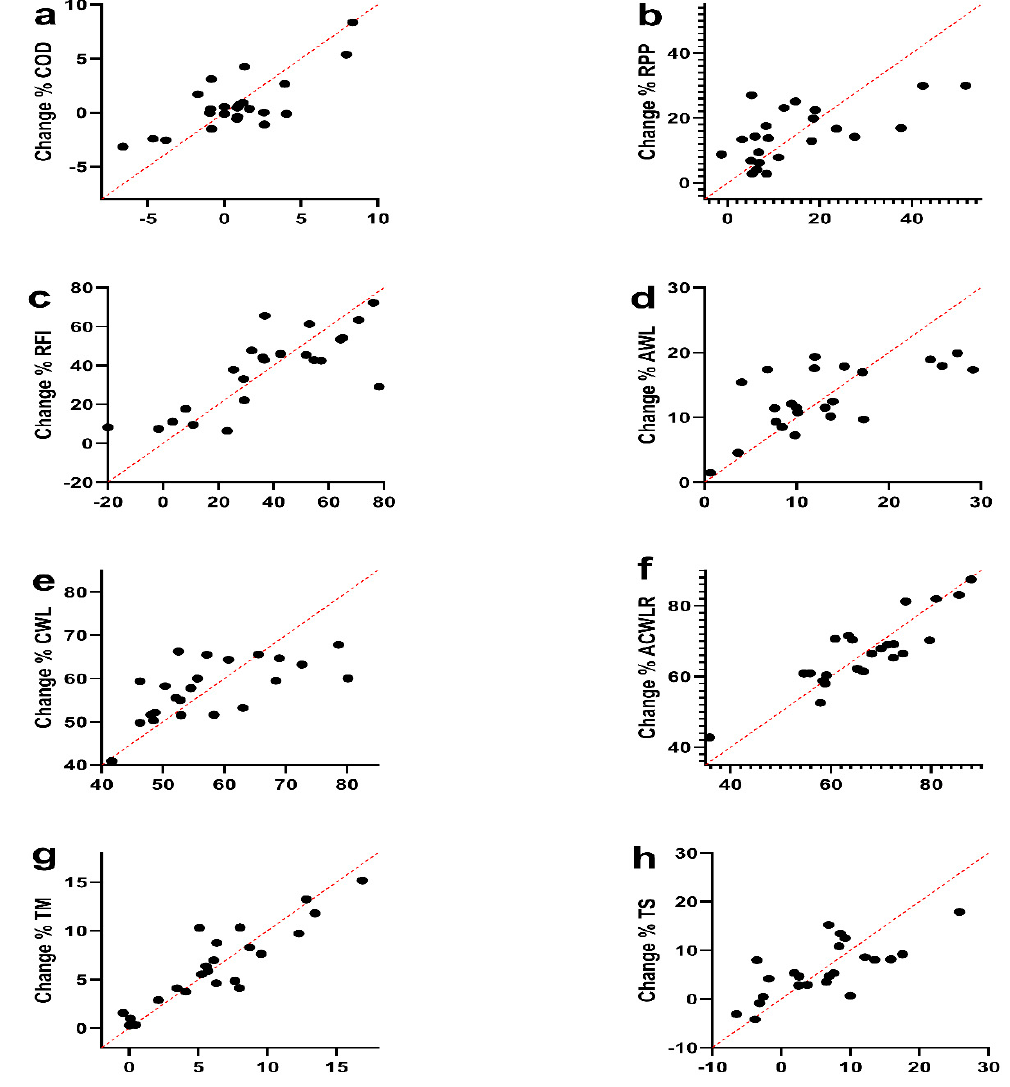
Figure 3. Multiple linear regression analysis was calculated to predict the percentage of change in fitness levels {i.e., COD (seconds), anaerobic power variables (watts), and workload parameter (A.U.)} based on accumulated workload parameters, baseline fitness levels, and the peak height velocity soccer player. ( a ); COD (seconds) = change of direction; ( b ); RPP (watts) = RAST of peak power; ( c ); RFI (%) = RAST of fatigue index; ( d ); AWL (A.U.) = acute workload; ( e ); CWL (A.U.) = chronic workload; ( f ); ACWLR (A.U.) = acute: chronic workload ration; ( g ); TM (A.U.) = training monotony; ( h ); TS (A.U.) = training strain; A.U. = Arbitrary